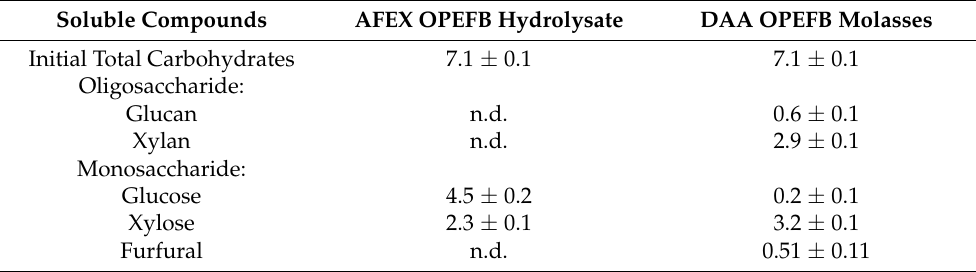
Table 3. Summary of major sugar and soluble compounds in AFEX OPEFB hydrolysate and DAA OPEFB